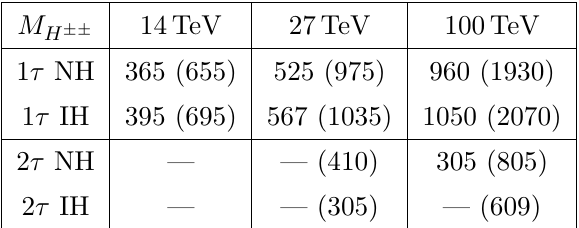
Table 4 . The reachable doubly charged Higgs mass (in the unit of GeV) at 5 (cid:27) signi(cid:12)cance for 1 (cid:28) and 2 (cid:28) channels and NH and IH neutrino mass patterns, at the 14 TeV LHC, 27 TeV LHC and FCC-hh. We assume L = 300 (3000) fb (cid:0) 1 .